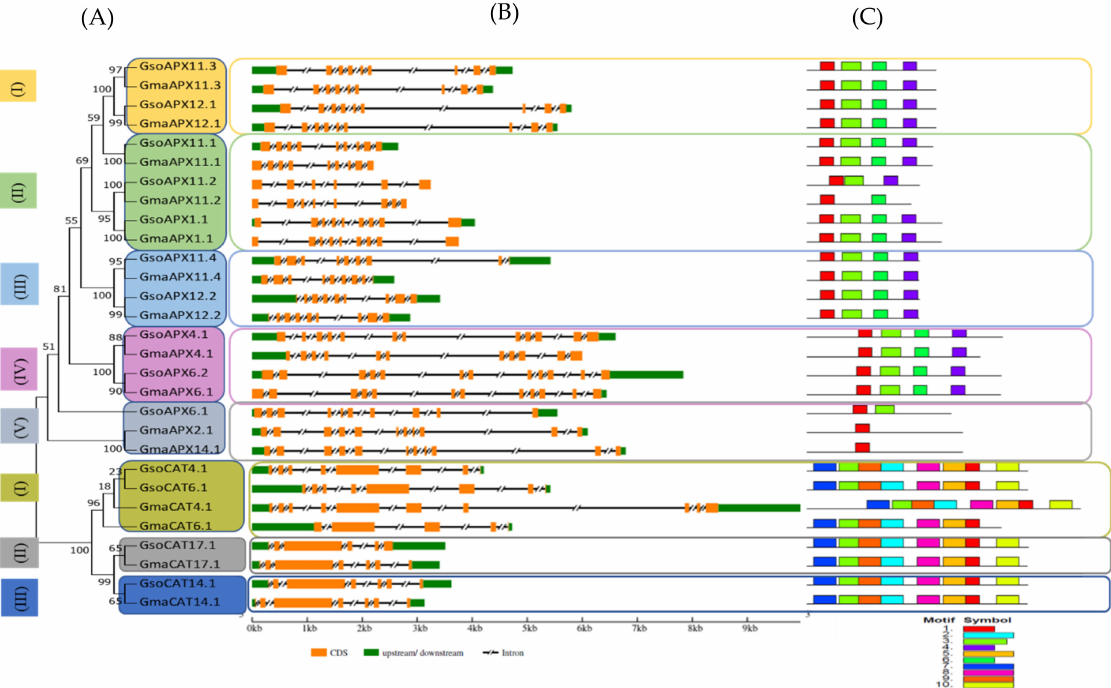
Figure 1. Phylogenetic relationship, exon–intron distribution/gene structure and conserved motifs in APX and CAT gene families in G. max and G. soja . ( A ) The phylogenetic tree of the APX gene family classified in to five clades highlighted with different colored boxes. ( B ) The untranslated region (UTR), with intron and exon distribution represented by a green box, black scored line and orange boxes, respectively. ( C ) Identification of the conserved motifs in APX and CAT genes. Each motif is presented by a particular